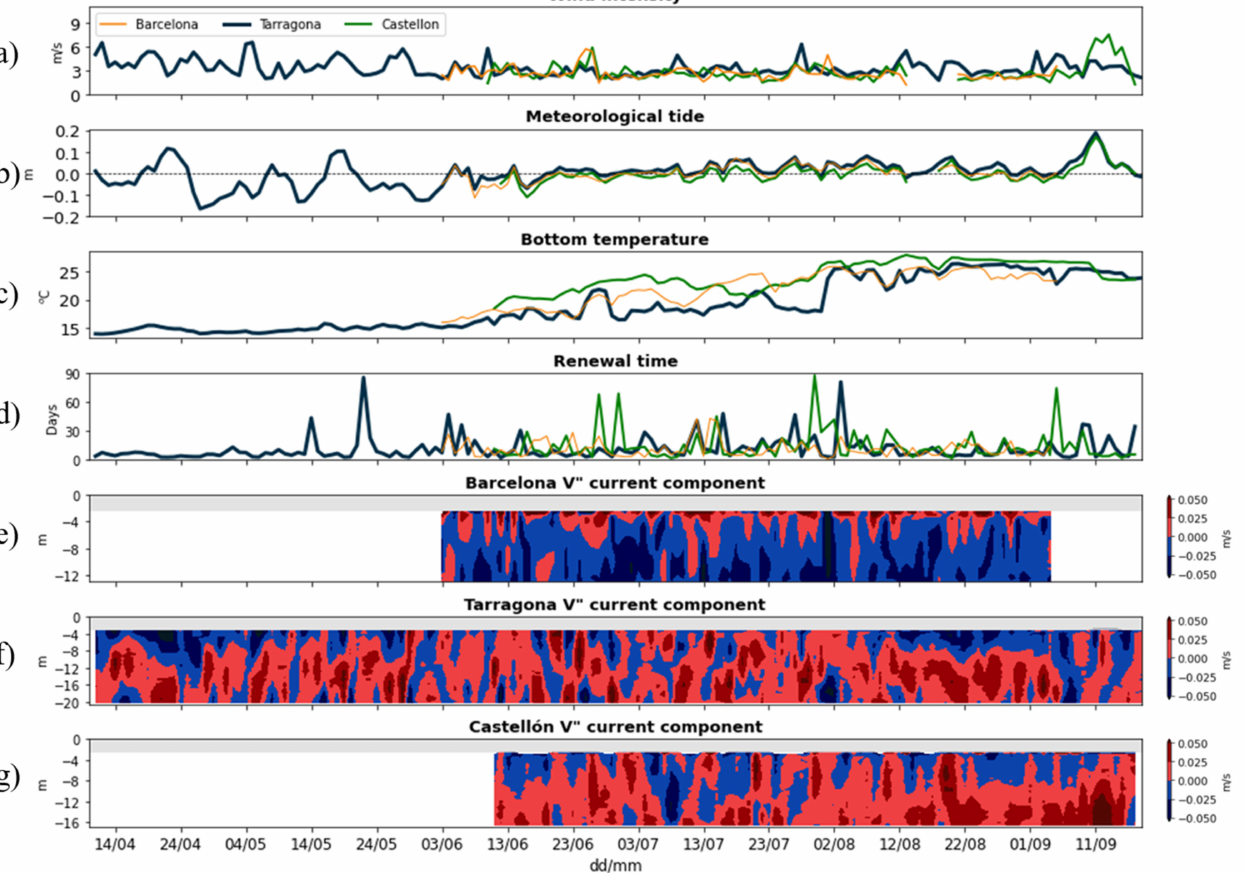
Figure 4. Time series (24 h filtered) of meteocean drivers from wind and tidal observations at Barcelona, Tarragona, and Castell ó n harbours, together with some of the more relevant circulation responses. From top to bottom: ( a ) wind speed, ( b ) meteorological tide, ( c ) bottom temperature, ( d ) renewal time and ( e – g ) v-component of the current